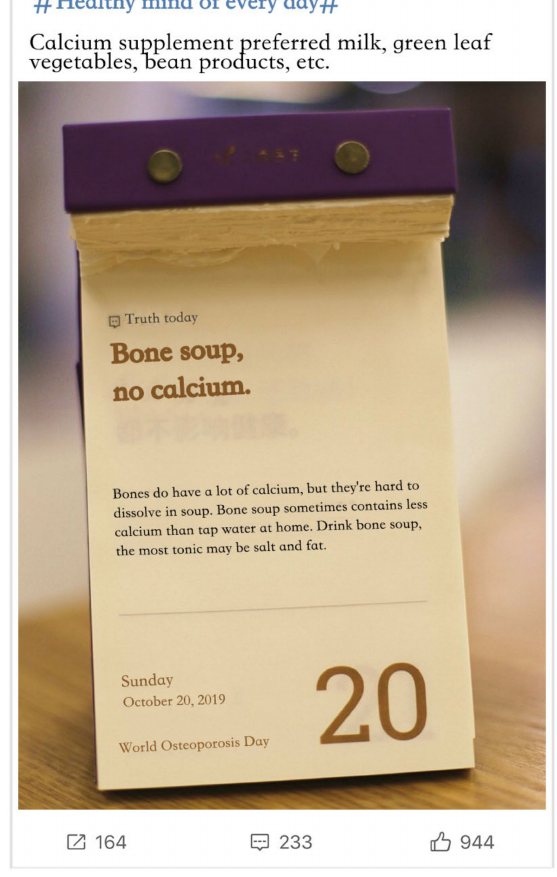
Figure 2. Health misinformation